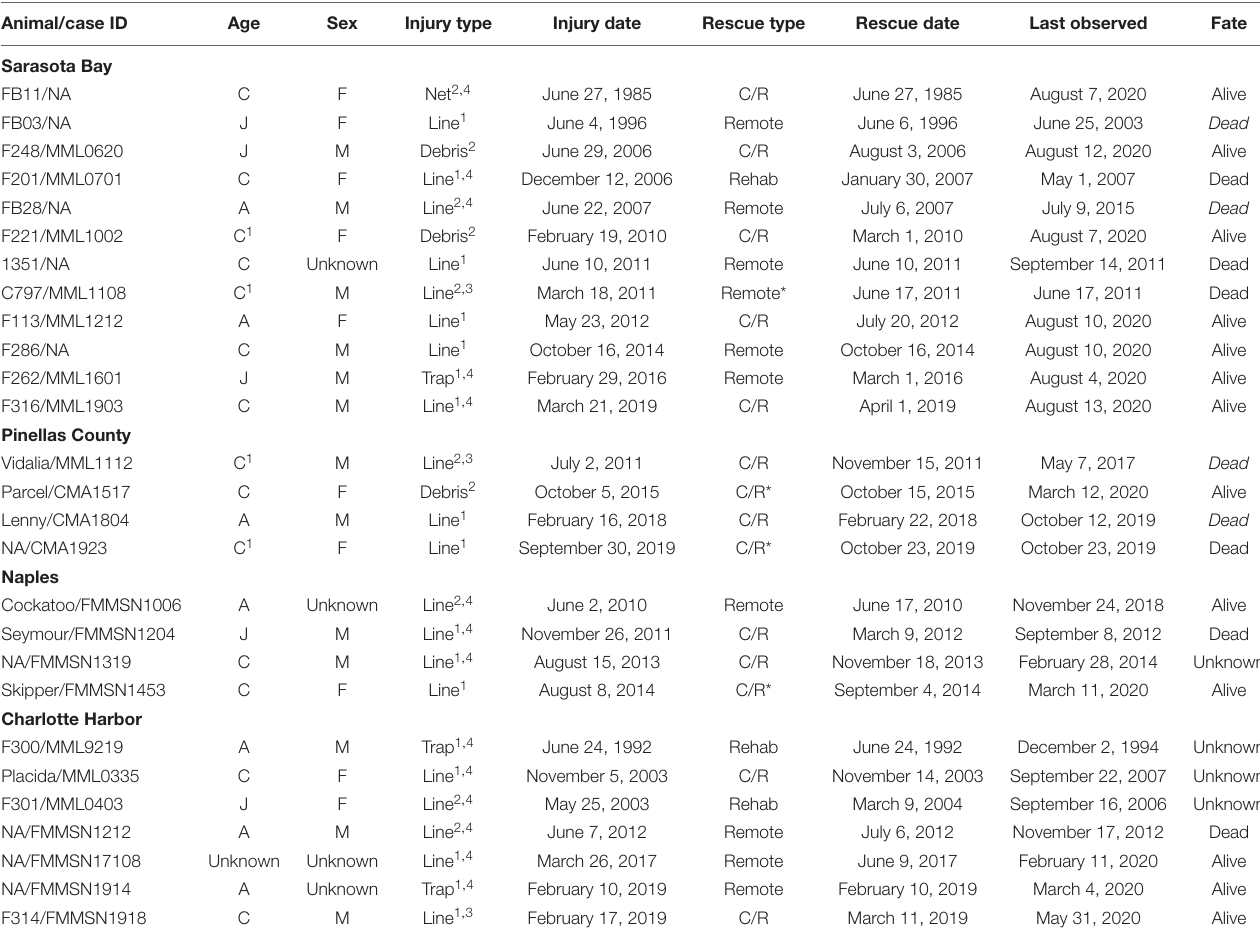
TABLE 1 | Intervention case